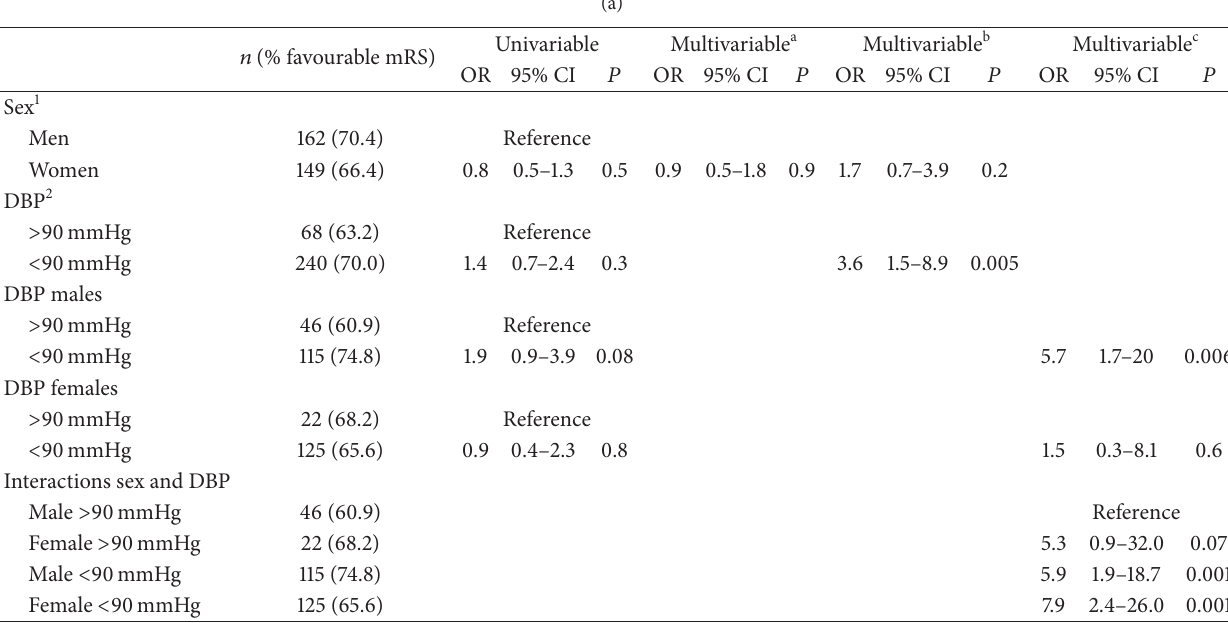
Table 3: Interaction by gender and diastolic blood pressure and influence on (a) 3-month favorable mRS and (b) 3-month